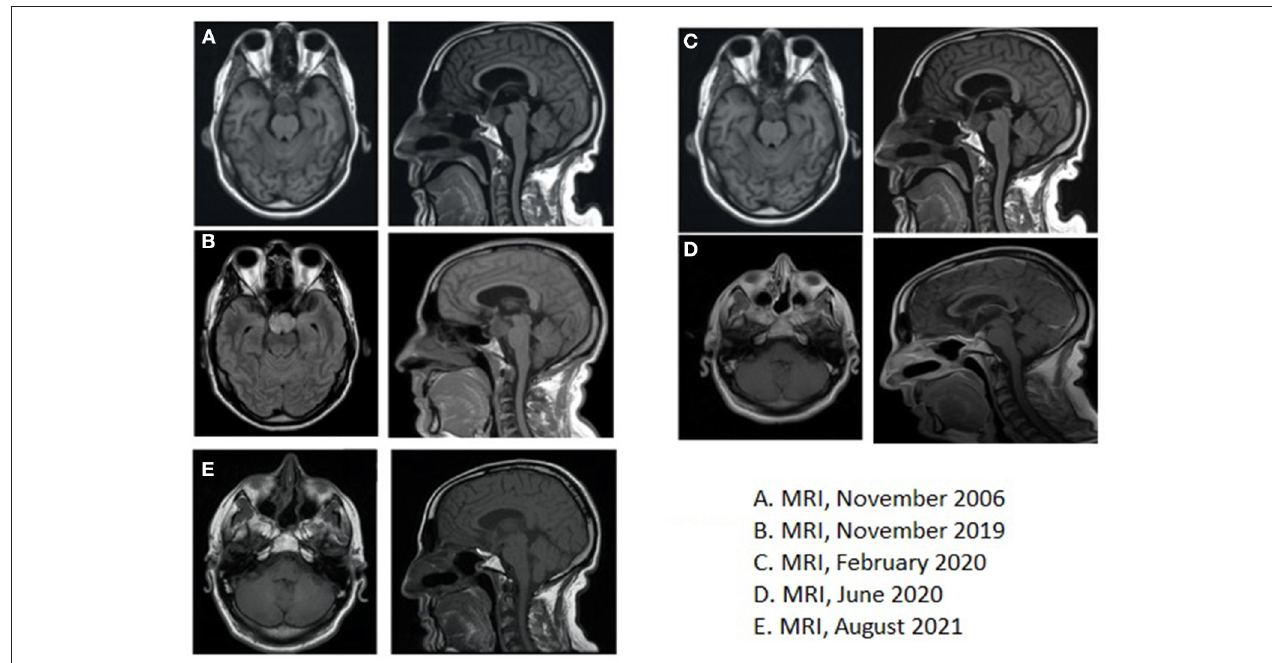
FIGURE 2 | (A) Brain magnetic resonance imaging (MRI), November 2006, at the time of the first diagnosis; (B) Brain MRI, November 2019, at the time of recurrence; (C) Brain MRI, February 2020, showing residual disease after post-second surgery, before starting medical therapy with BRAF- and MEK-inhibitors; (D) Brain MRI, June 2020, at the time of partial response after 4 months of medical therapy; (E) Brain MRI, August 2021, after 18 months of medical